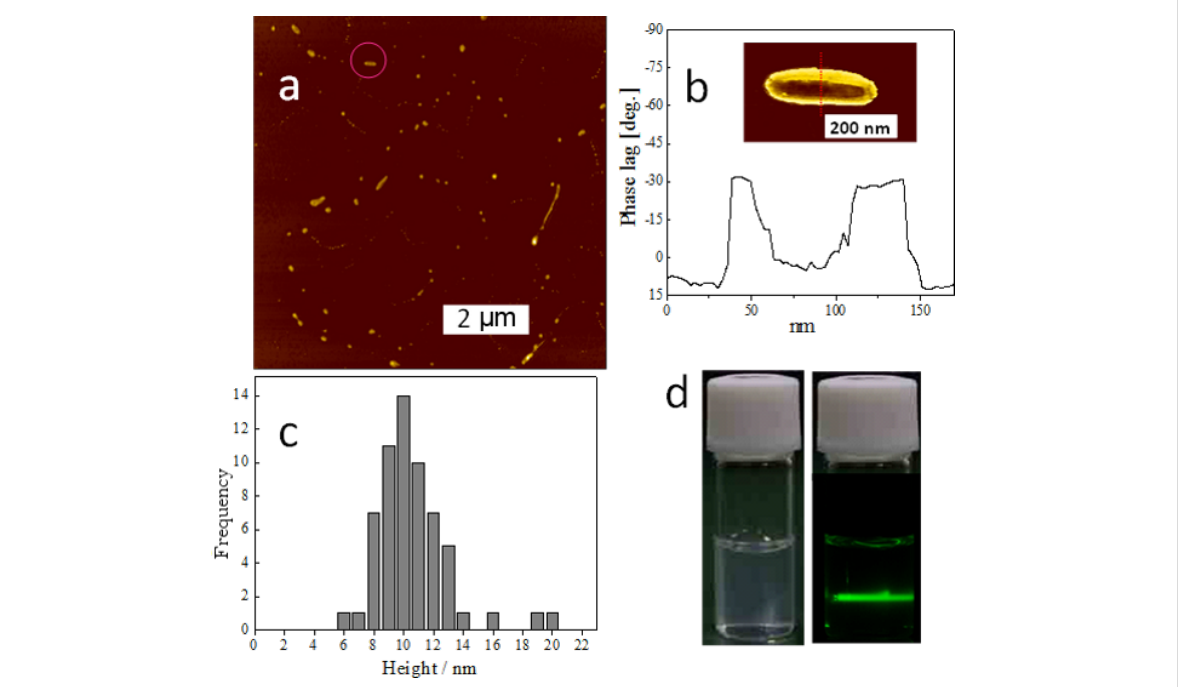
The subsequent ARGET ATRP was carried out by using ascorbic acid (AA) as the reducing agent and anisole as the solvent. Ascorbic acid is insoluble in anisole, hence, the reduc- tion of the Cu(II) complex takes place at the surface of solid ascorbic acid. The slow reaction rate of this